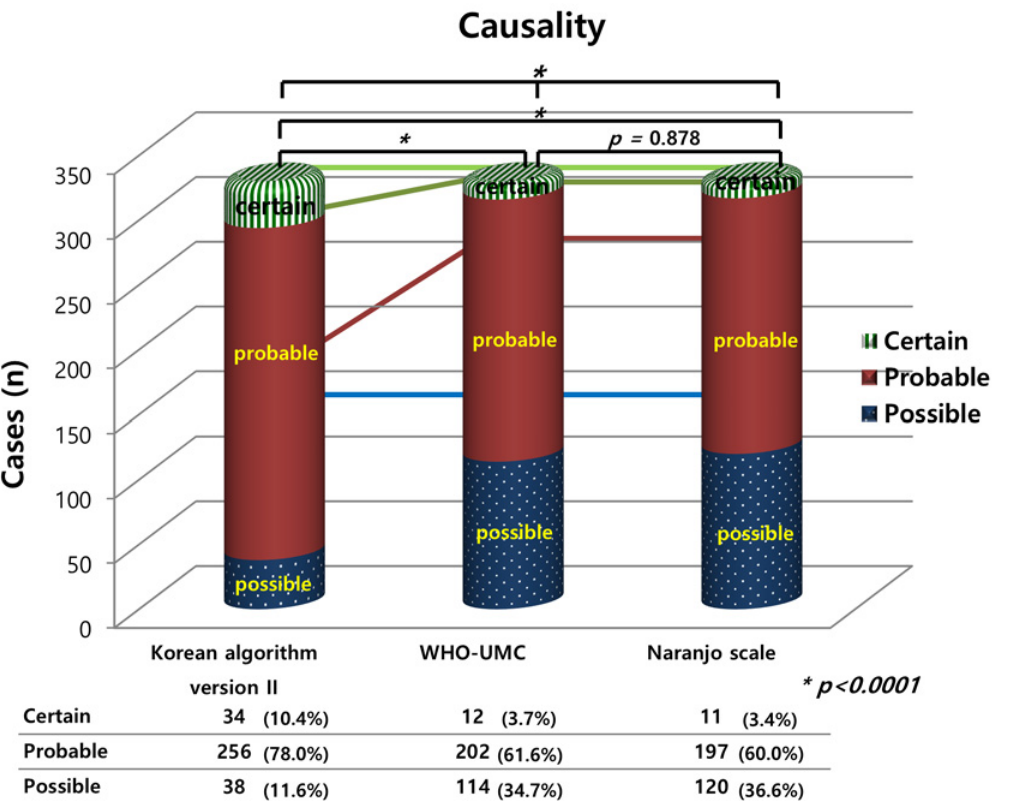
Fig 1. Characteristics of drug-induced adverse reactions (D-ADRs): causality versus evaluation tools. WHO-UMC, World Health Organization- Uppsala Monitoring Centre; D-ADRs, drug-induced adverse drug reactions (not including contrast media adverse drug reactions); * chi square test.